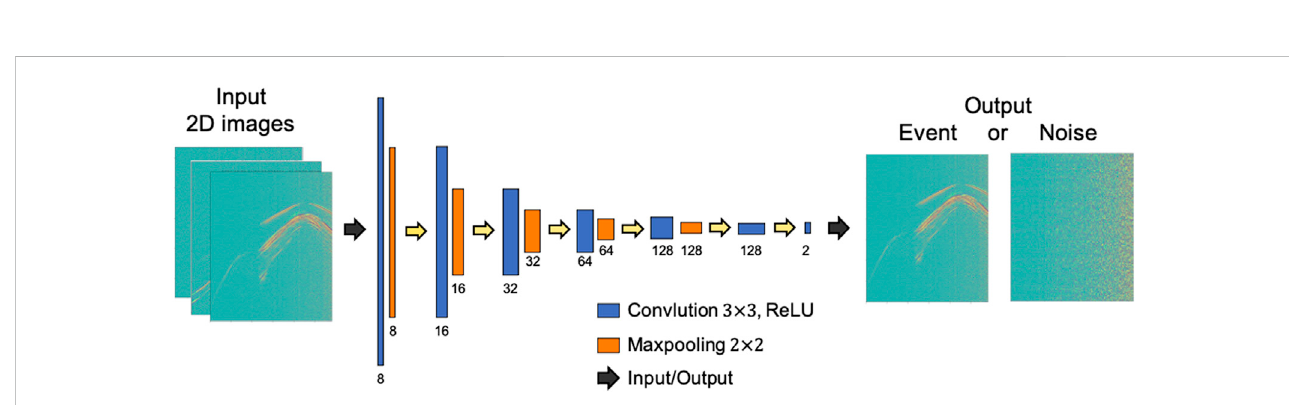
FIGURE 3 CNN architecture used for event detection. The input is 2D images created from the DAS data in windows, and the output is binary (event or noise).